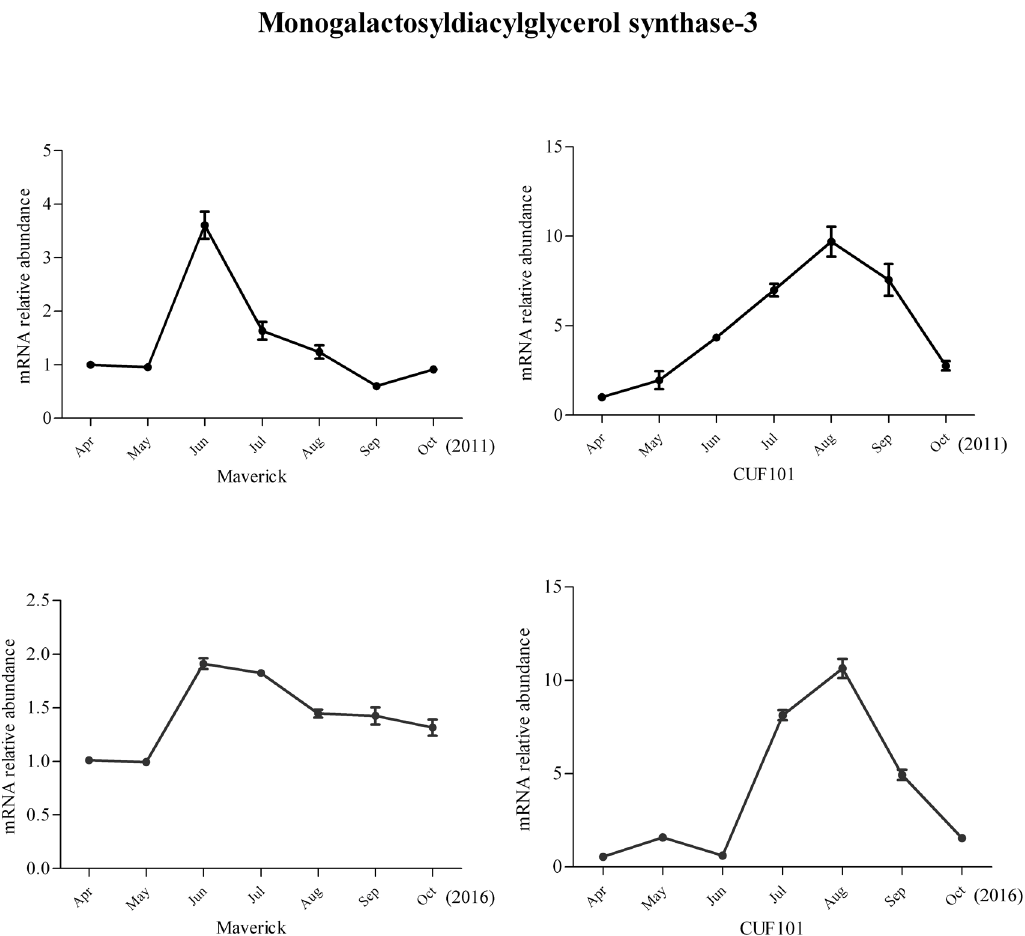
Fig 7. mRNA abundance of monogalactosyldiacylglycerol synthase-3 in Maverickand CUF101 varietiesfrom April to October in 2011 and 2016. * and ** indicate significantdifference betweenJuly, August, September, and June at p < 0.05and p <